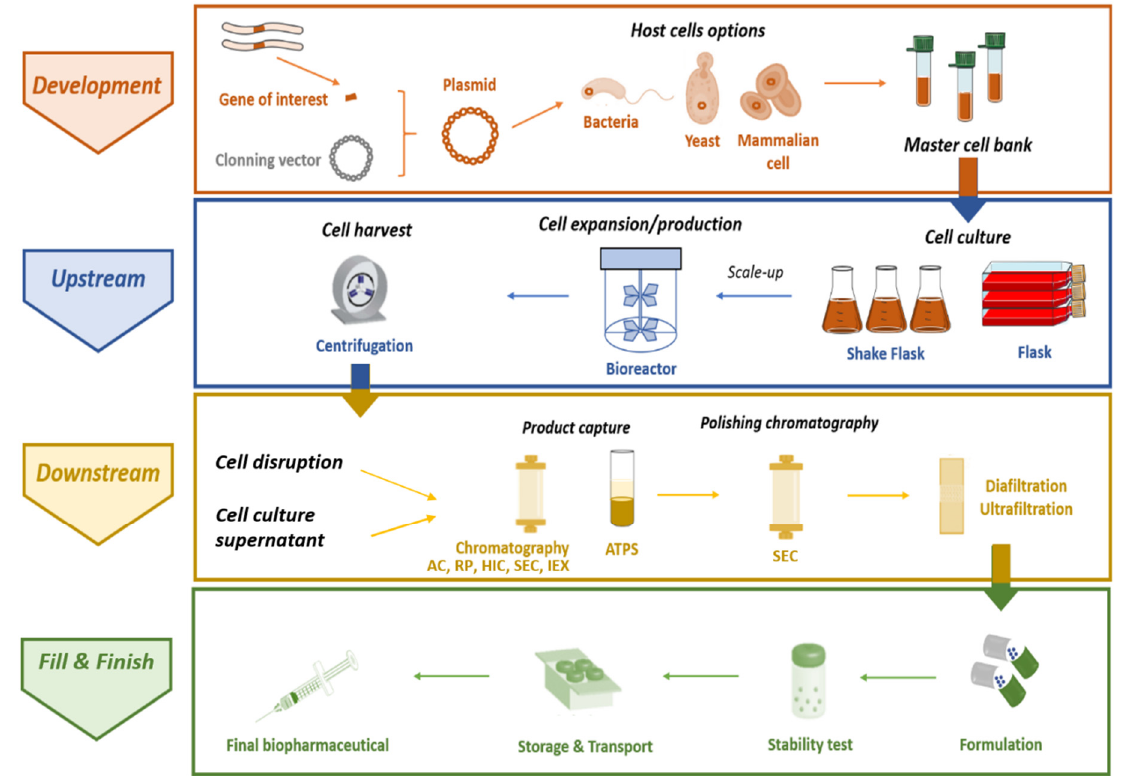
Figure 2. Overview of the manufacturing of IFN-based biopharmaceuticals (ATPS–Aqueous two-phase system; AC–Affinity chromatography; IEX–Ion-exchange chromatography; HIC–Hydrophobic interaction chromatography; RP–Reverse phase chromatography; SEC–Size exclusion chromatography).